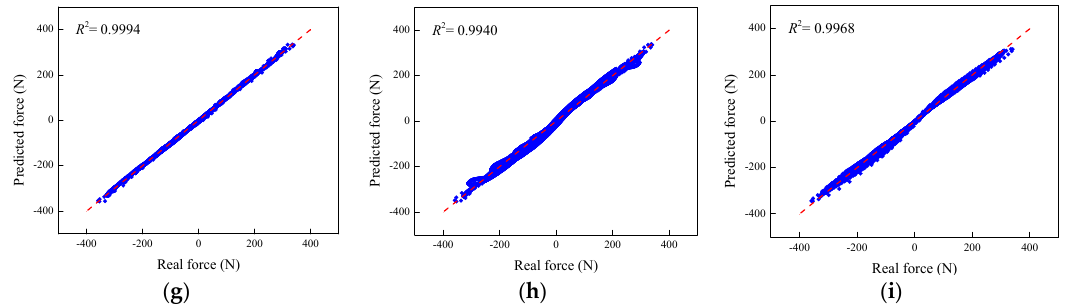
Figure 30. Regression analysis of the phenomenological models. ( a ) Kelvin–Voigt model, ( b ) four-parameter viscoelastic model, ( c ) rheological model, ( d ) BW model, ( e ) improved BW model, ( f ) Dahl model, ( g ) improved LuGre friction model, ( h ) strain stiffening model, and ( i ) hyperbolic hysteresis model.